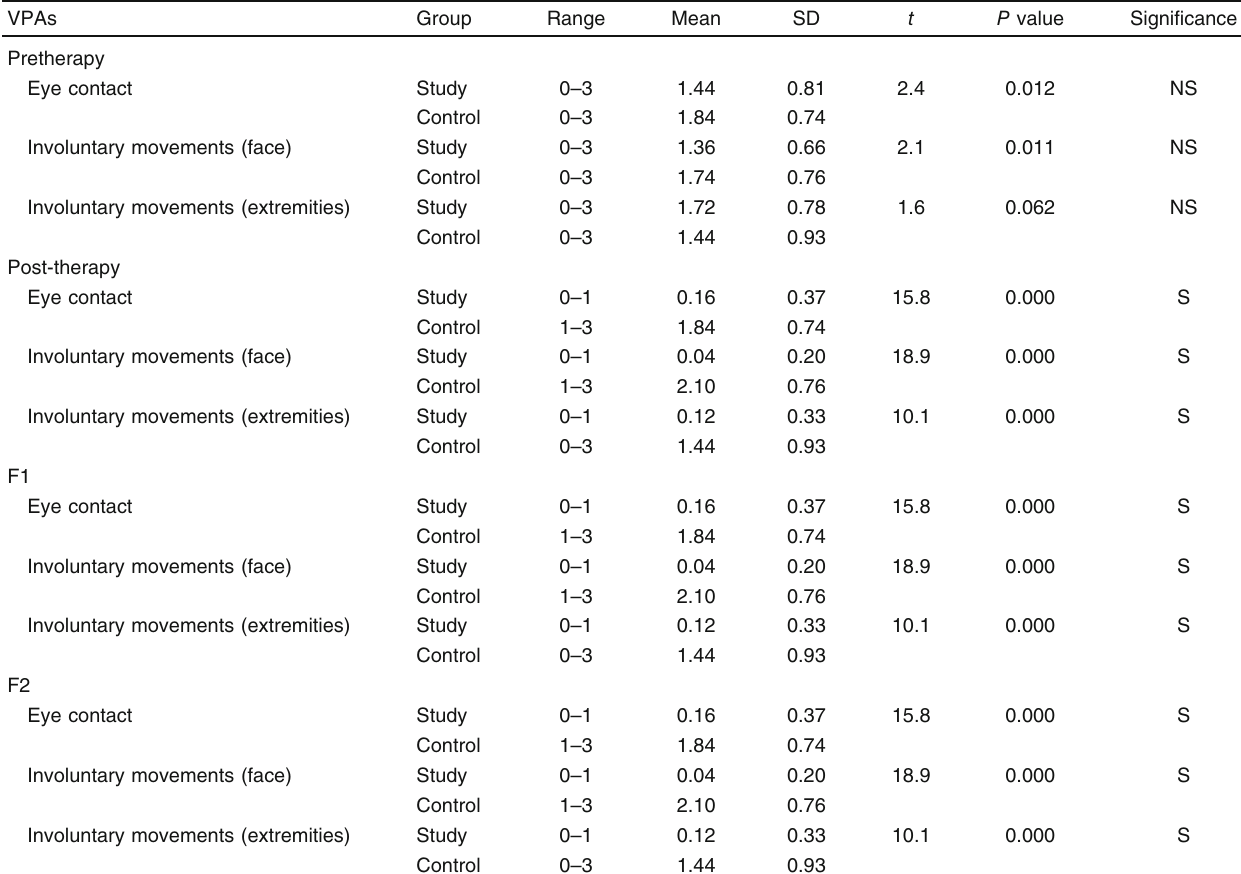
Table 3 Comparison between the study group and the control group as regards visual perceptual assessment VPAs